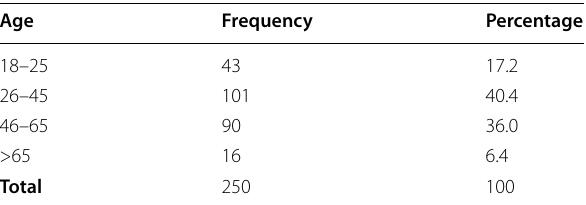
Table 2 Age profile of patients with recurrent malaria cases in Sir Yahaya Memorial Hospital Birnin Kebbi from 2016 to 2020